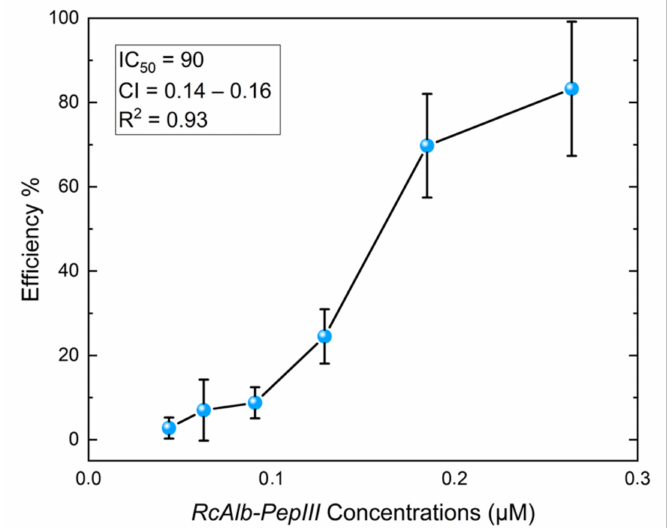
Figure 2. Inhibitory effect of RcAlb -PepIII on the development of Haemonchus contortus . The graph shows the inhibition of development of H. contortus larvae at different concentrations of RcAlb -PepIII. L1 and L3 stages were quantified relative to the respective untreated control. Bars represent the means of three independent experiments. Error bars indicate the standard deviations. Half inhibition concentration (IC 50 ) in µ M, confidence interval (CI), and coefficient of determination (R 2 ) were added at the top of the